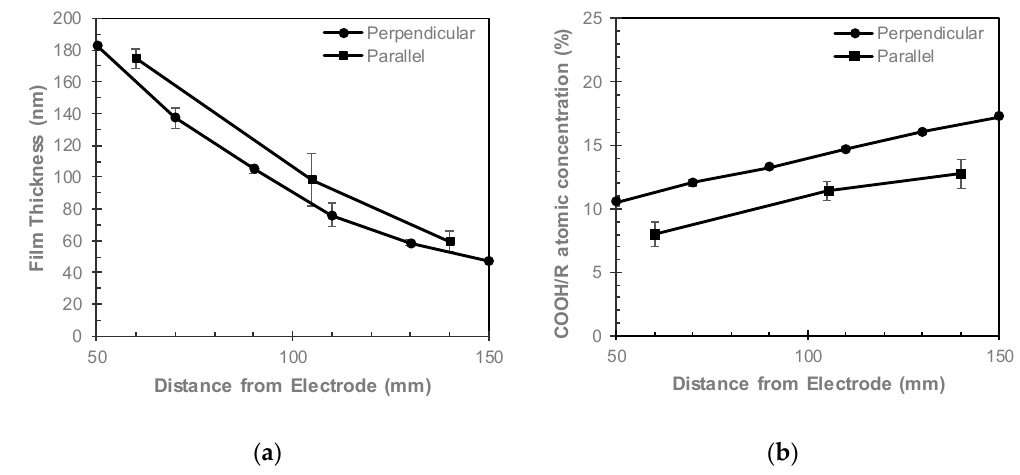
Figure 7. ( a ) Film thickness and ( b ) COOH / R concentrations of ppAAc films deposited in parallel and perpendicular electrode configurations as a function of distance from the electrode (error bars ± standard deviation).